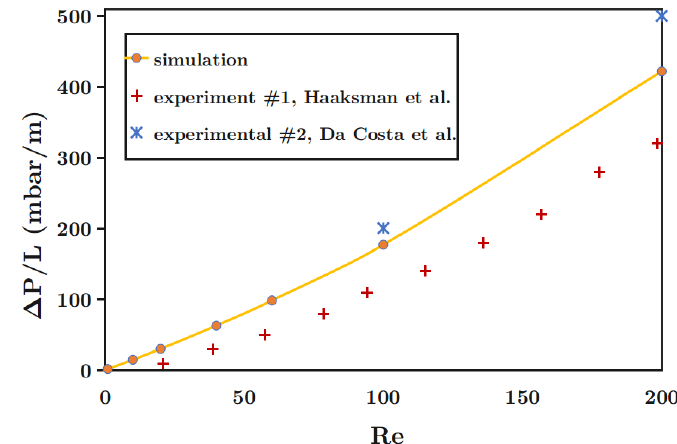
Figure 10. Comparison of simulated pressure drop gradient for cylindrical spacer-filled channel over one currugation with the experimental data for Conwed-1 commercial spacer measured by Da Costa et al. [49] and the experimental data for Conwed-2 commercial spacer measured by Haaksman et al. [51].